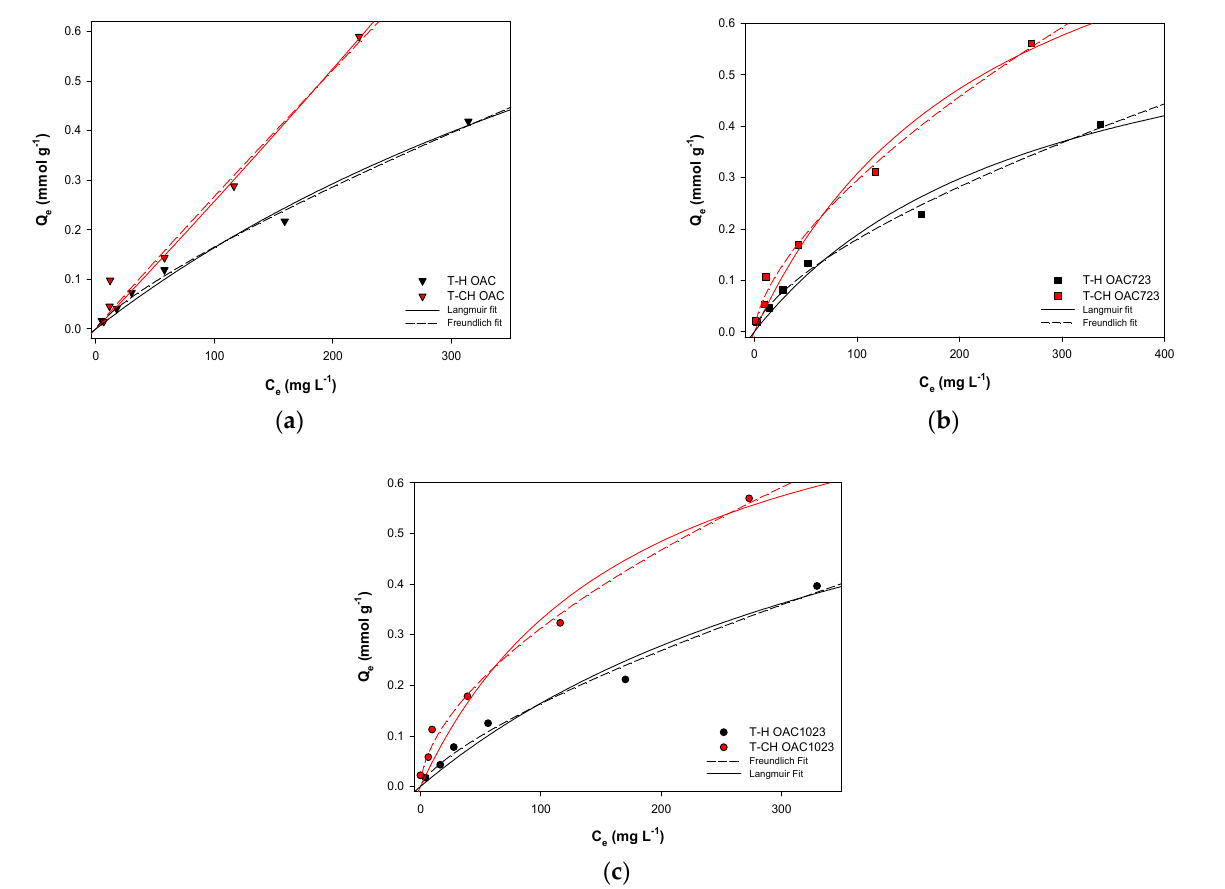
Figure 4. Liquid-phase isotherms for the adsorption of solutions of toluene in hexane (T-H) and cyclohexane (T-CH) for